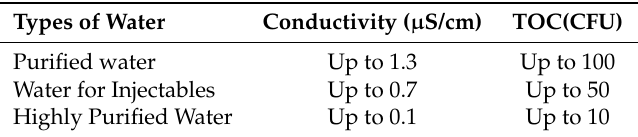
Table 1. Types and main parameters of pure